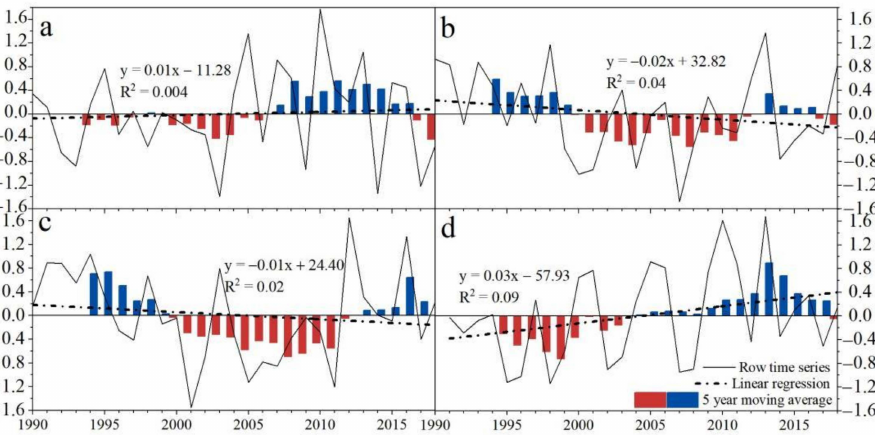
Figure 8. Quarterly variations of spring ( a ), summer ( b ), autumn ( c ), and winter ( d ) based on SPEI03 in northeast China (NEC) from 1990 to 2018.